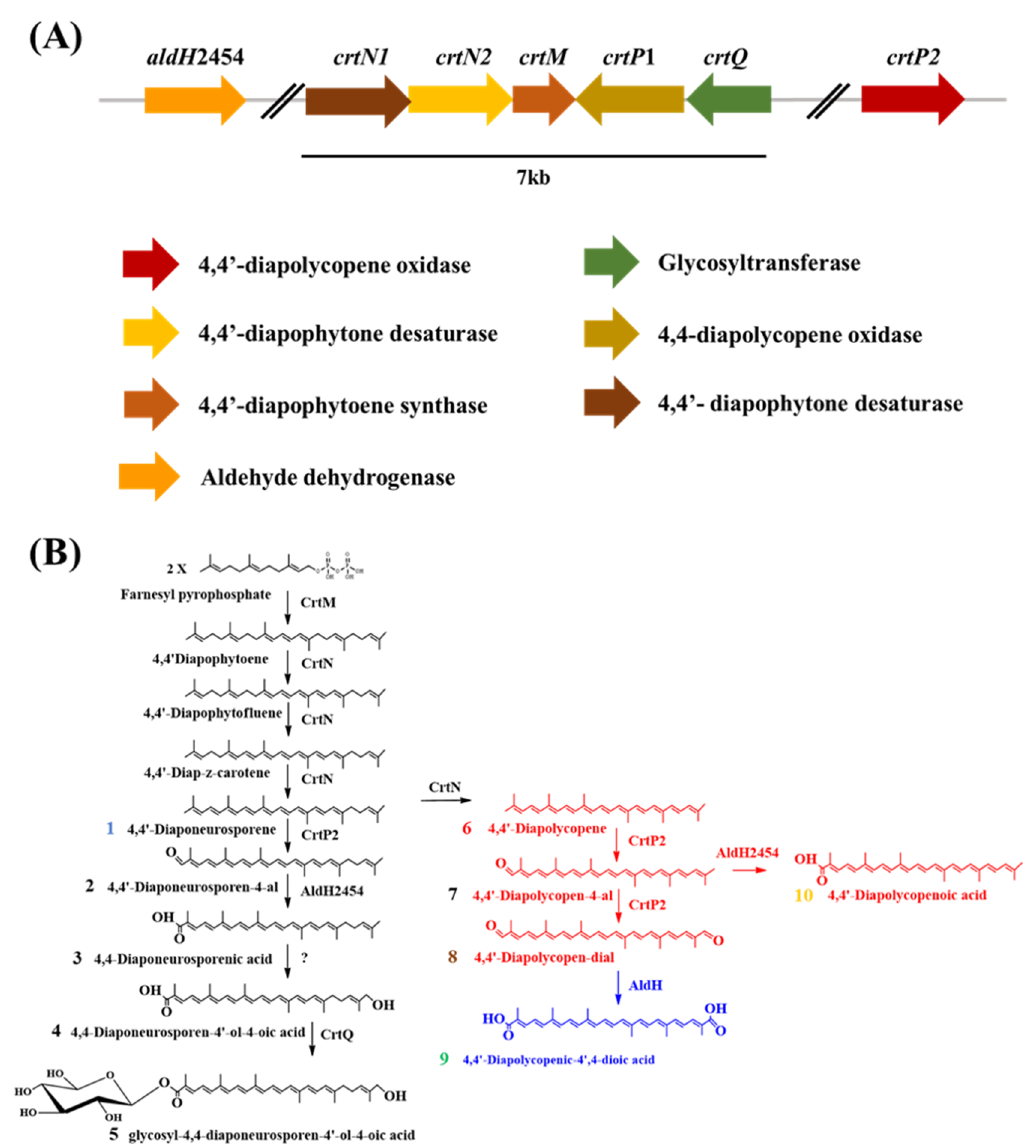
Figure 1. Proposed biosynthesis gene clusters and pathway of glycosyl-4,4 ′ -diaponeurosporen-4 ′ -ol- 4-oic acid. ( A ) A whole gene cluster comprising five carotenoid pathway genes was presented with translational direction of a gene. ( B ) The biosynthetic pathway of glycosyl-4,4 ′ -diaponeurosporen-4 ′ - ol-4-oic acid in P. faecalis (in black) and the extended carotenoid pathway with CrtP2 and AldH2454 enzymes of P. faecalis (red) and with AldH enzyme of S. aureus (blue) in heterologous E. coli . The question mark indicates a possibility of a missing enzyme or a spontaneous step.